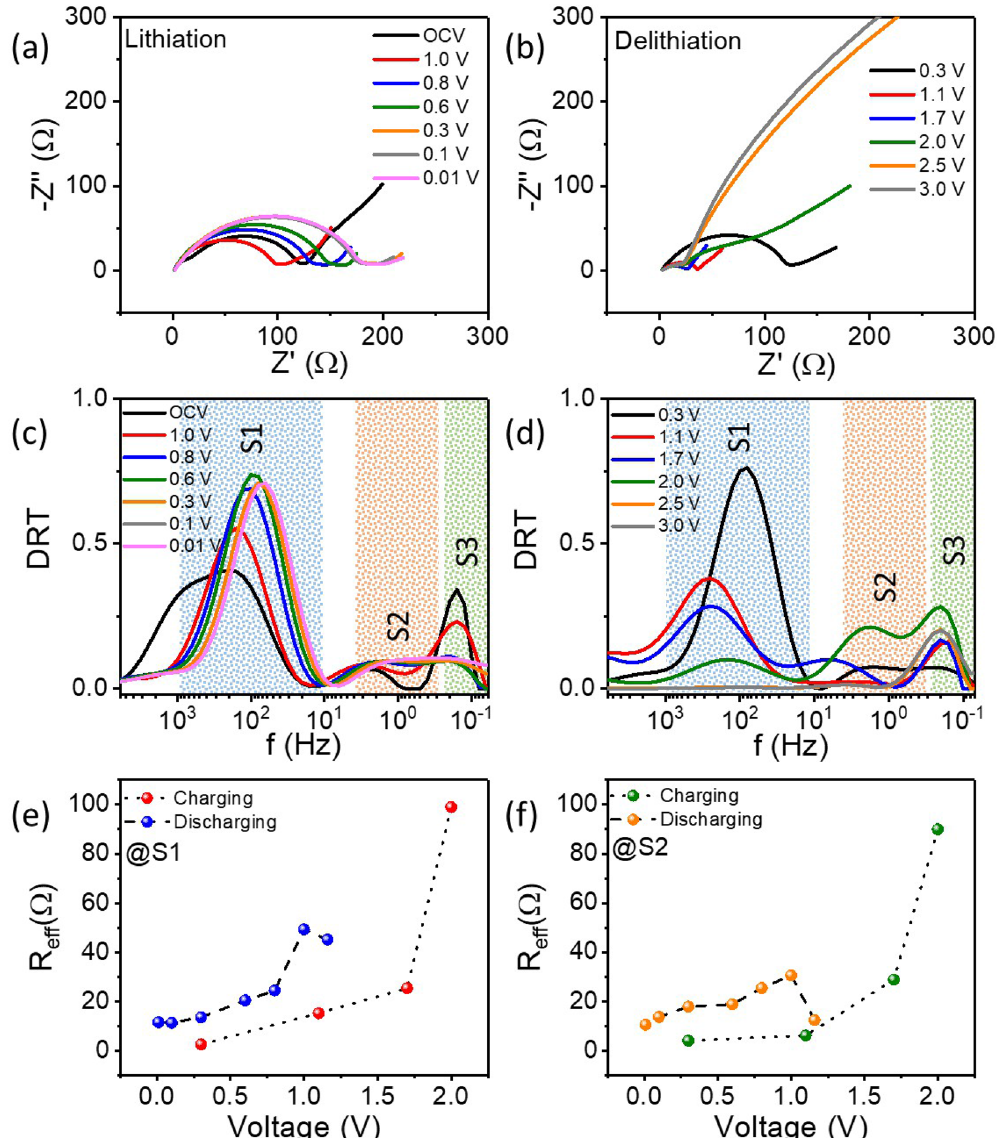
parameter (λ = 0.06334). The shadings in ( c,d ) are for illustration only. The voltage dependence of the effective resistances as obtained for peak S1 and S2 are shown in ( e,f ) respectively. The dash lines in ( e,f ) are guide to the